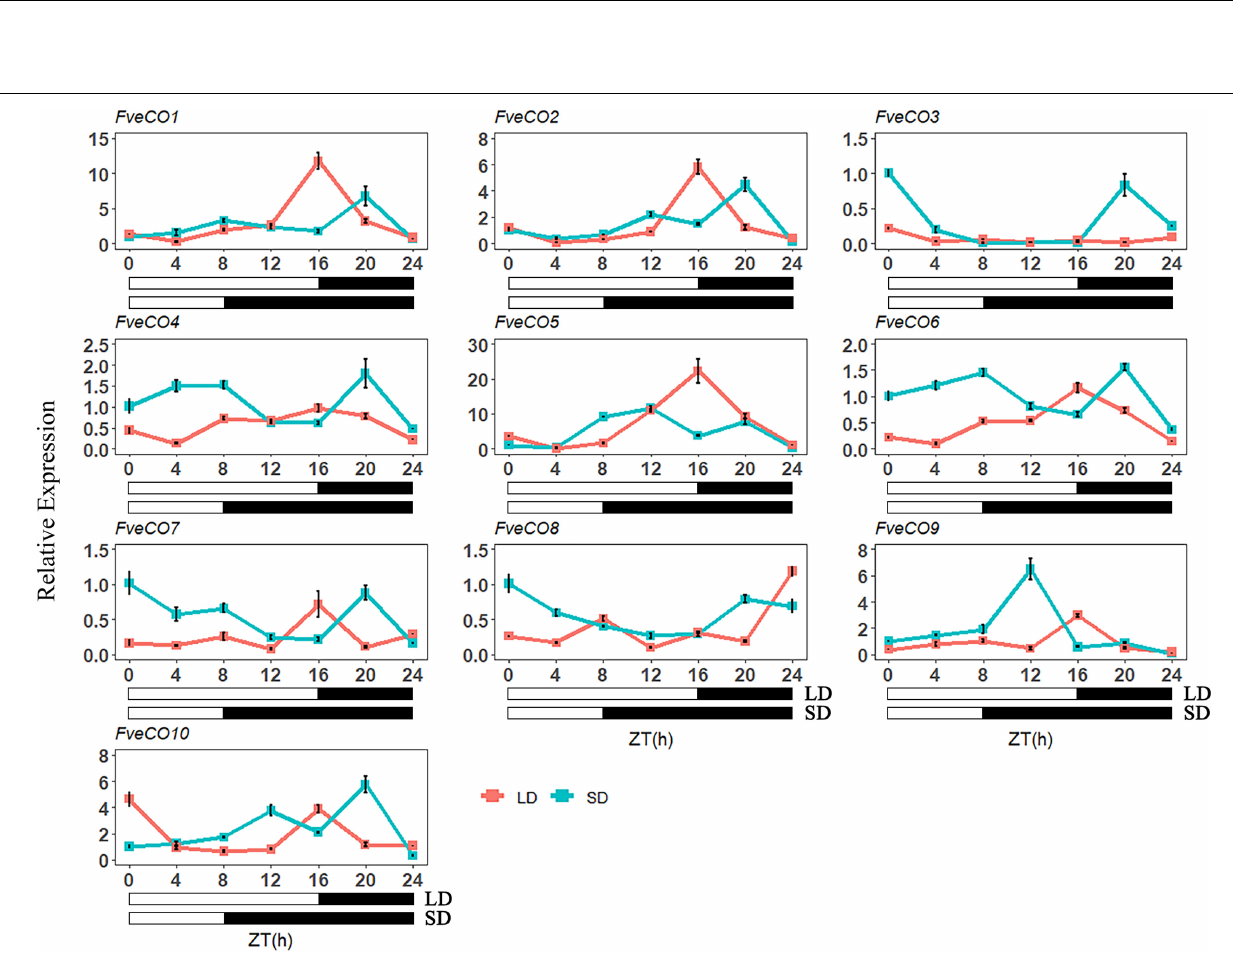
FIGURE 7 | Expression of FveCOs in different woodland strawberry tissues. Different colors of heat map represent the expression levels. The tissues of the samples are as follows: R, root; P, petiole; L, leaf; F, flower; SA, shoot apex; GF, green fruit; WF, white fruit; TF, turning red fruit; RF, red fully fruit. For each gene, the expression level was set to 1 in the root, and the corresponding fold changes were calculated in other tissues. The gene expression heatmap was generated on the log base 2 average expression fold values.